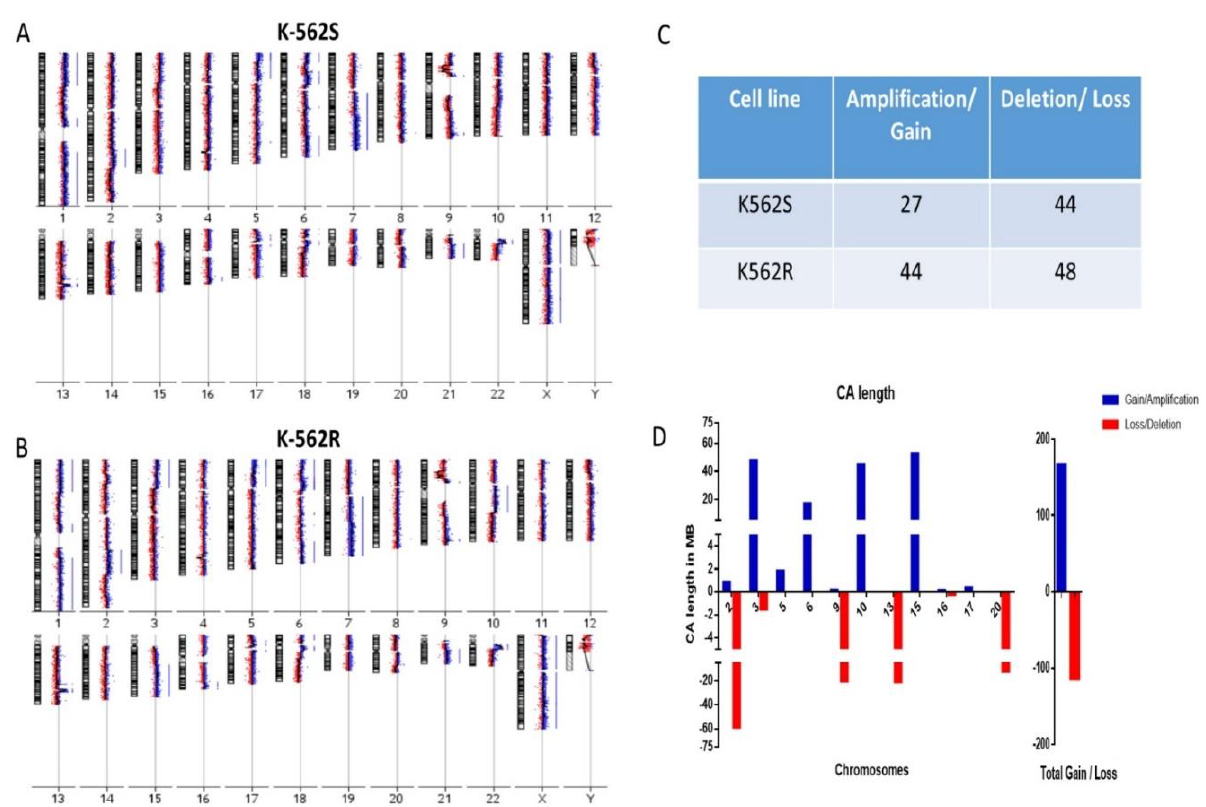
Figure 1. Array CGH profile: ( A ) K562S, ( B ) K562R generated from Agilent Cyto genomics software (blue-amplification/gain, red-deletion/loss). ( C ) Total losses and gains in the K562S and K562R cells. ( D ) Histogram representing the altered DNA content due to chromosomal aberrations differentially present in K562R cells (blue-amplified/gain, red-de- letion/loss).